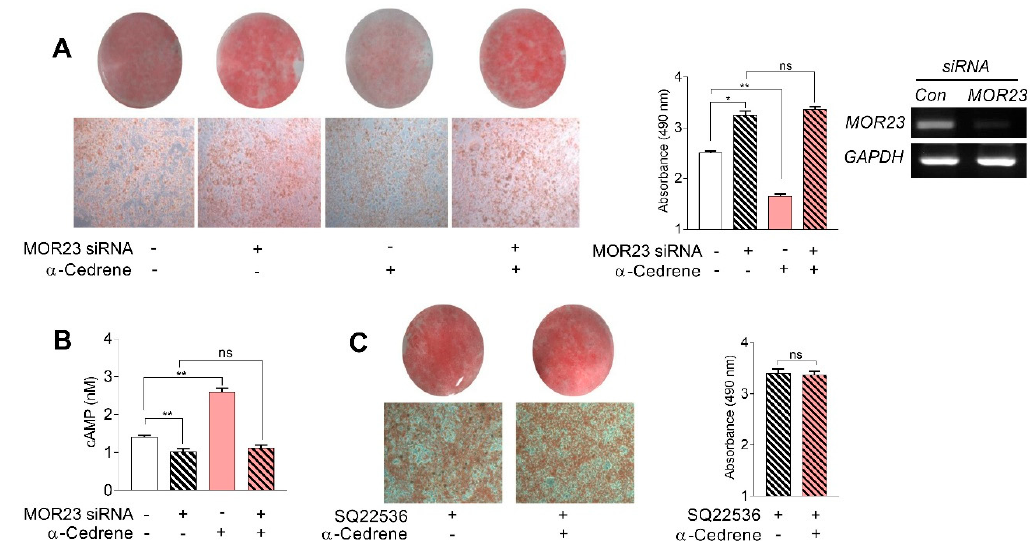
Figure 1. A reduction in mouse olfactory receptor 23 (MOR23) expression by specific siRNA increases intracellular lipid accumulation and abrogates the lipid-lowering effect of α -cedrene in 3T3-L1 cells. 3T3-L1 preadipocytes were transfected with MOR23 siRNA, stimulated to differentiate in culture 2 days after transfection in the presence of 100 µ M α -cedrene or 50:50 ( v / v ) dimethyl sulfoxide (DMSO)/acetonitrile (vehicle). Oil Red O staining and cAMP assay were performed after adipocyte induction. ( A ) Oil red O staining of 3T3-L1 cells transfected with MOR23 siRNA with or without 100 µ M α -cedrene. Representative photomicrographs ( × 100) are shown in the left panel. Right panel shows spectrophotometric quantification of Oil Red O staining. The knockdown efficiency by siRNA was monitored by semi-quantitative reverse transcription-polymerase chain reaction (RT-PCR). ( B ) Cyclic adenosine monophosphate (cAMP) level of 3T3-L1 cells transfected with MOR23 siRNA with or without 100 µ M α -cedrene. ( C ) Oil red O staining of 3T3-L1 cells exposed to adenylyl cyclase (ADCY) inhibitor for 24 h with or without 100 µ M α -cedrene. Representative photomicrographs ( × 100) are shown in the left panel. Right panel shows spectrophotometric quantification of Oil Red O staining. The full-length gels are presented in Supplementary Figure S1. The values represent the means ± SEM, n = 3. Significant differences between groups are indicated by asterisks; * p < 0.05; ** p < 0.01; ns, not significant ( p > 0.05).